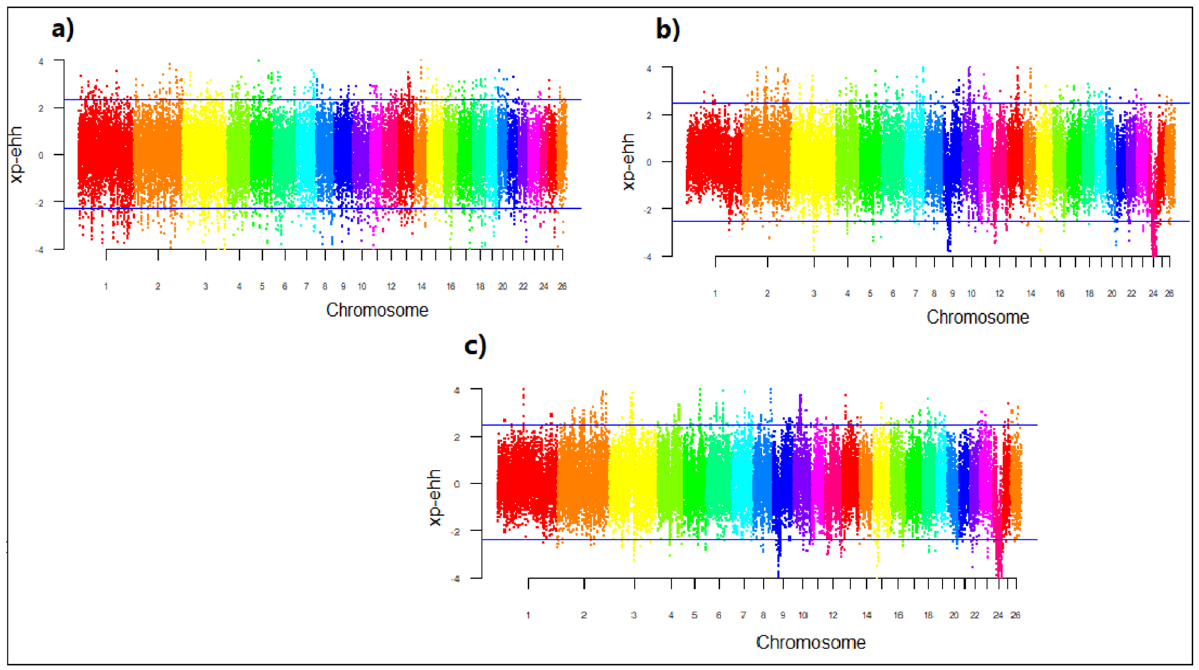
Figure 5. Genomic distribution of standardized cross-population extended haplotype homozygosity (xp-EHH) scores on 26 sheep autosomes pairwise: ( a ) IR and IN breeds, ( b ) IR and AF breeds, ( c ) IN and AF breeds. For breed abbreviations, see Table 1.